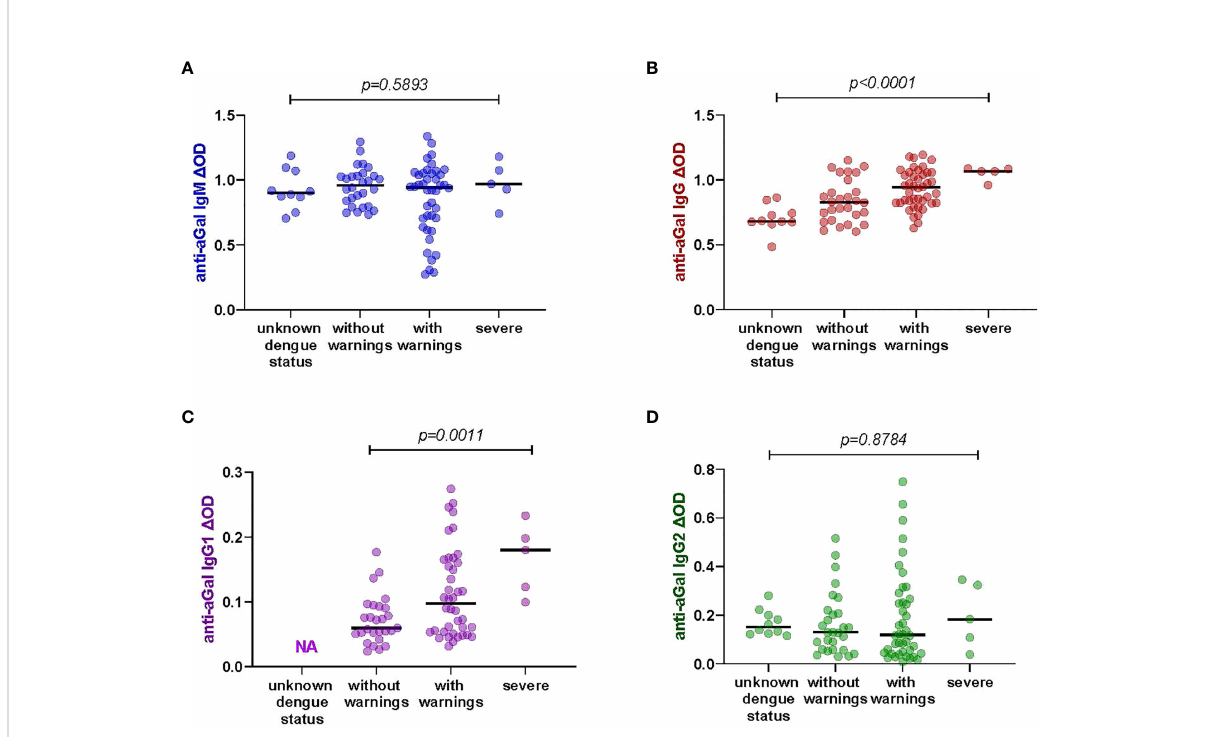
FIGURE 2 Speci fi c anti-aGal IgM, IgG, IgG1, and IgG2 levels by dengue fever classi fi cation; those with unknown dengue status (n-=10), dengue without warnings (n=28), dengue with warnings (n=42), and severe dengue (n=5). (A) Blue color - anti-aGal IgM antibody levels. (B) Brown color - anti- aGal IgG antibody levels. (C) Purple color - anti-aGal IgG1 antibody levels. (D) Green color - anti-aGal IgG2 antibody levels. Individual anti-aGal antibody levels are represented by the colored dots and horizontal black lines represent medians of group individual antibody responses. Antibody levels were measured in units of OD (optical density). “ p ” values <0.05 were measured using the two-way ANOVA